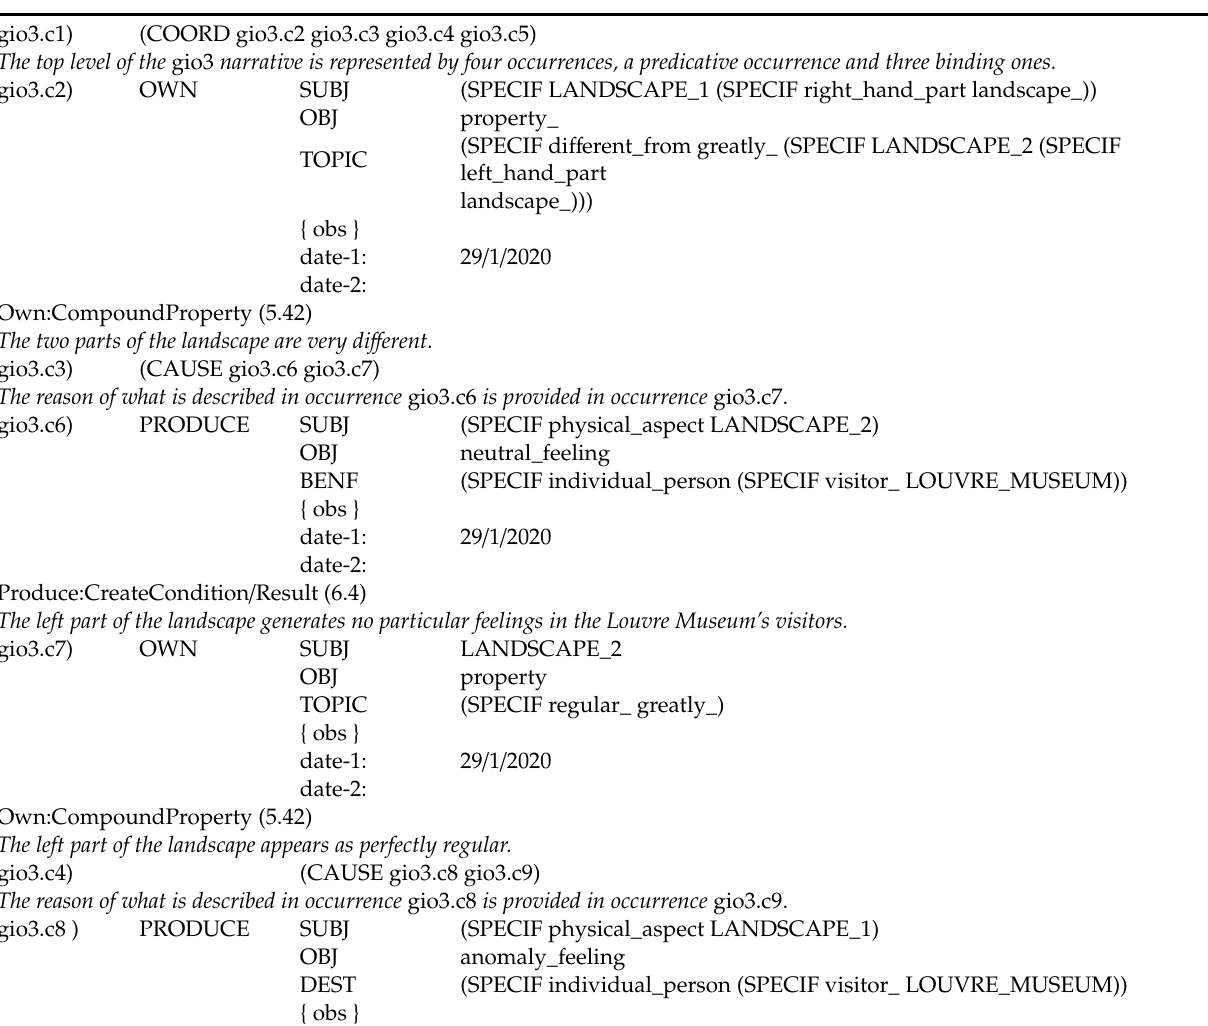
Table 4. The right landscape and Mona Lisa’s